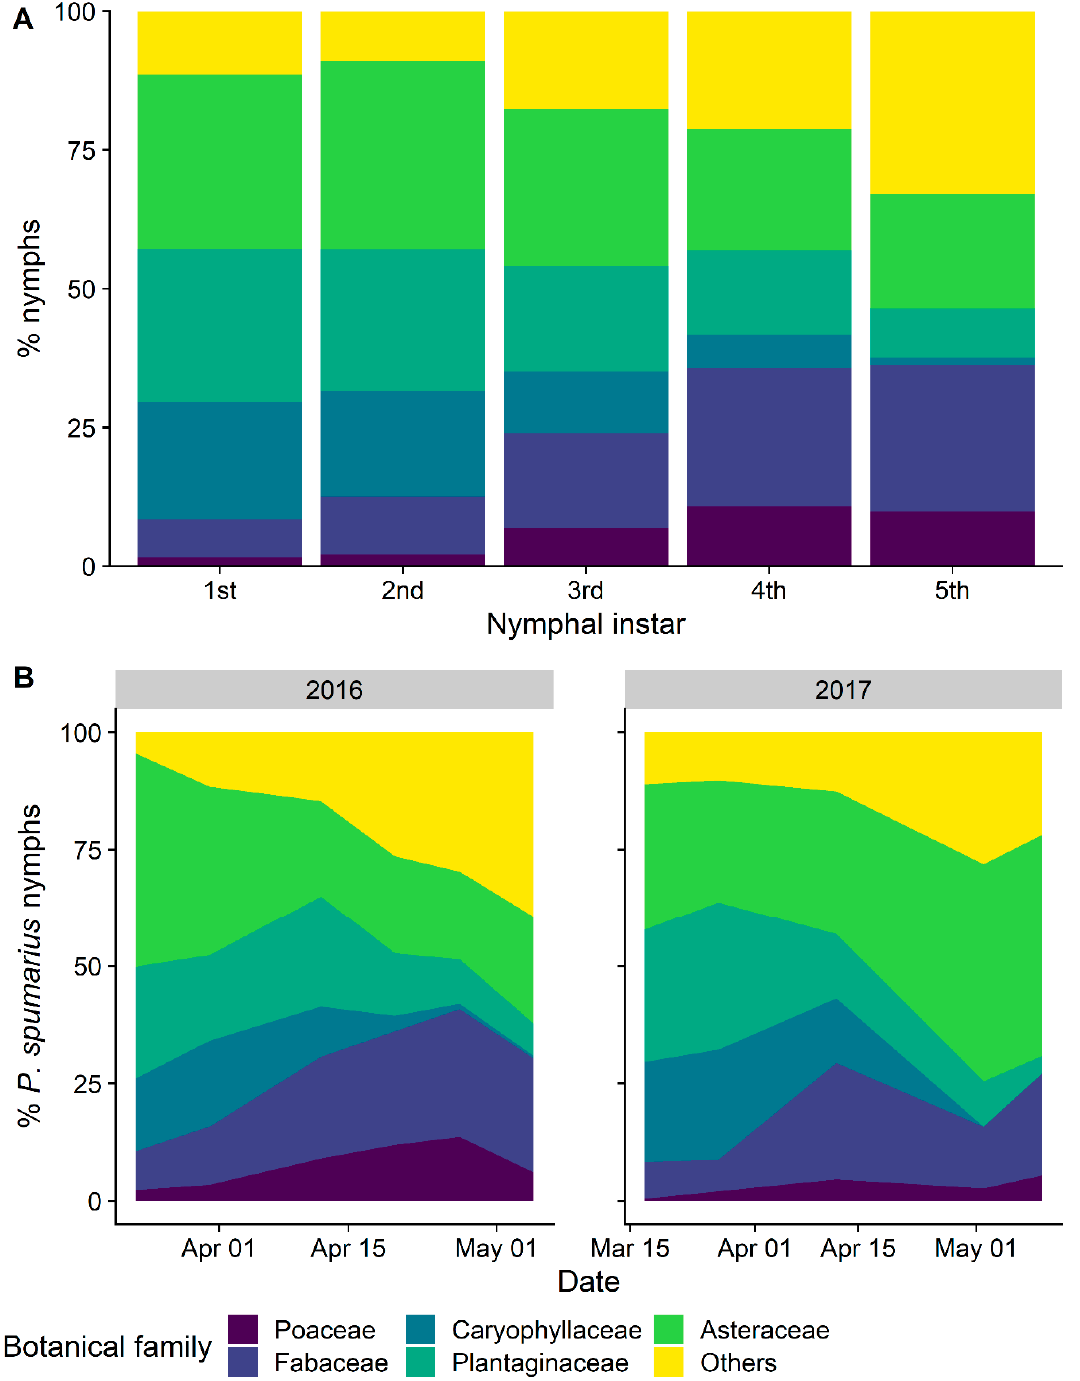
Figure 5. Relative percentages of nymphs of Philaenus spumarius on the most selected plant families in vineyard in the 2016–2017 samplings. ( A ) per instar; ( B ) throughout the sampling period (March–May).